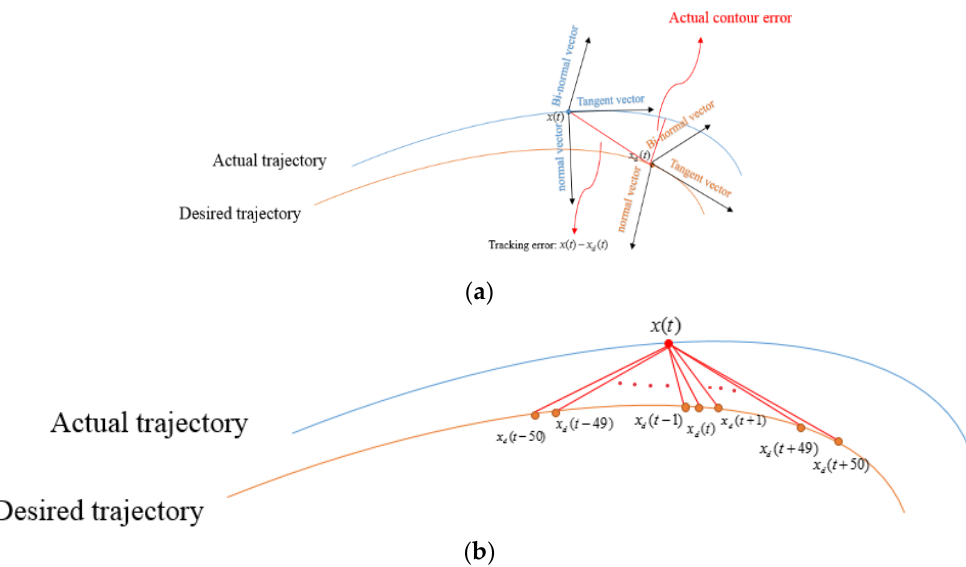
Figure 5. Illustration of on-line contour error, ( a ) Concept map of contour error; and, ( b ) illustration of calculation actual online contour error.